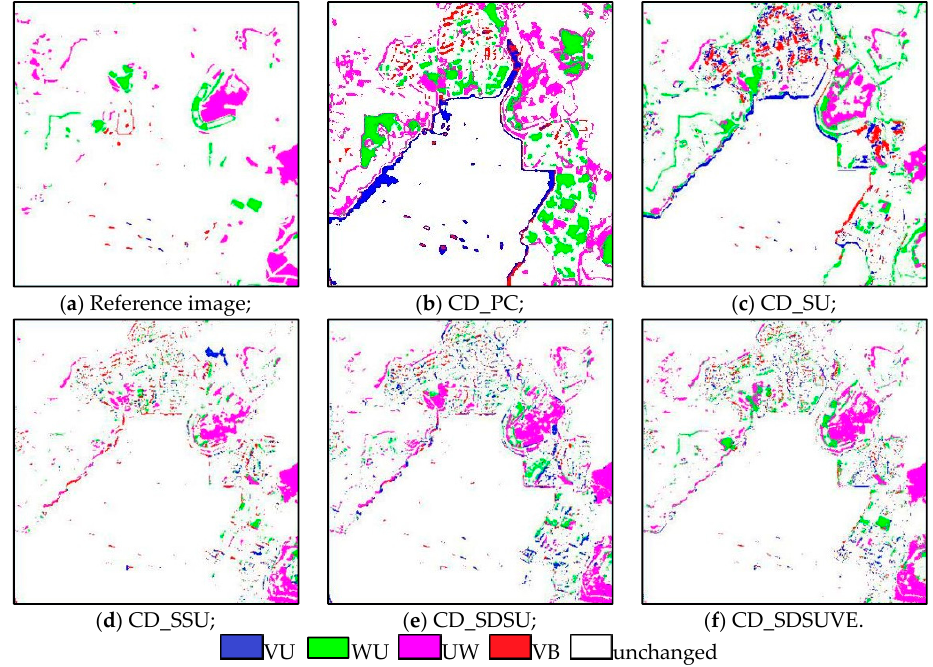
Figure 8. The abundances in the entire images: ( a ) urban (U), ( b ) vegetation (V), ( c ) water (W), ( d ) bare soil (B), ( e ) vege- tation–urban (VU), ( f ) vegetation–bare soil (VB), ( g ) water–urban (WU) and ( h ) urban–water (UW).